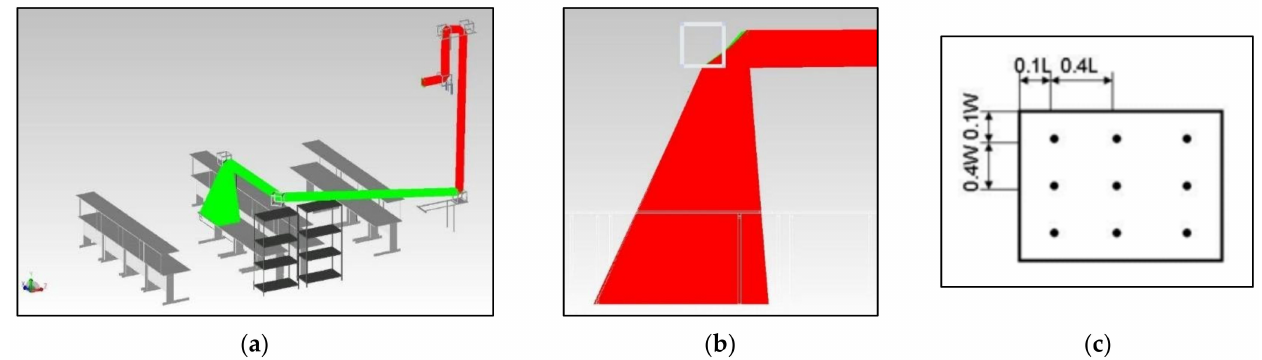
Figure 20. ( a ) Prescribed optical path in the field; ( b ) side view of the freeform reflector module and the target plane; and ( c ) prescribed measurement point on the target plane.